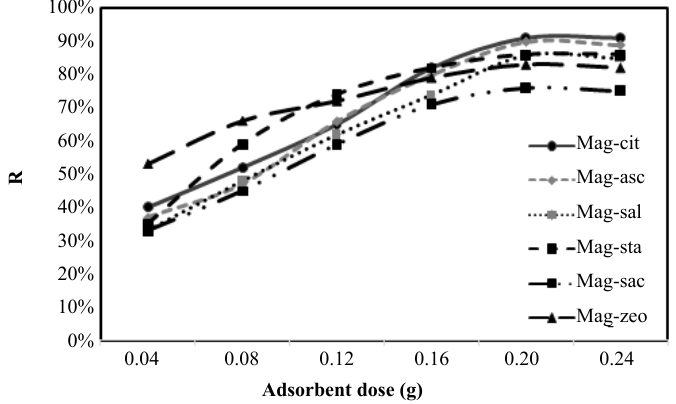
Adsorbent dose (g) Fig. 11. Effect of adsorbent dosage on the removal of Co(II)